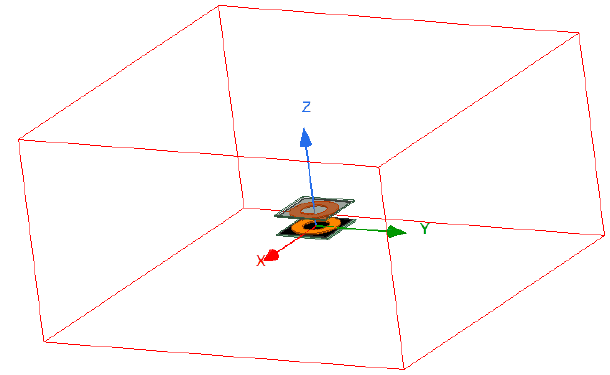
Figure 3. Simulation diagram of setting boundary conditions.